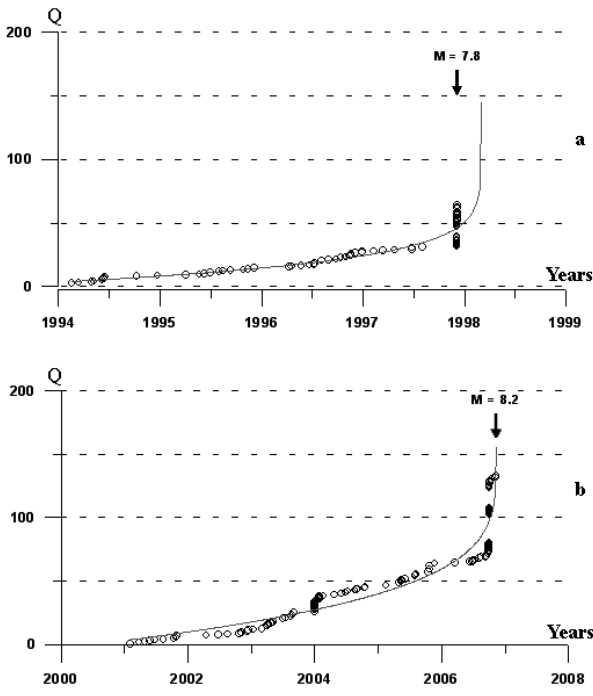
Fig. 8. Plots of Benioff strain curves Q (solid lines) and experimental Q values (circles) for (a) the Kronotskoe and (b) Simushirskoe earthquakes. The arrows mark the moments of main Figure 8. Plots of Benioff strain curves Q (solid lines) and experimental values 3 (circles) for (a) the Kronotskoe and (b) Simushirskoe earthquakes. The arrows are mark the 4 moments of main shocks. 5 6